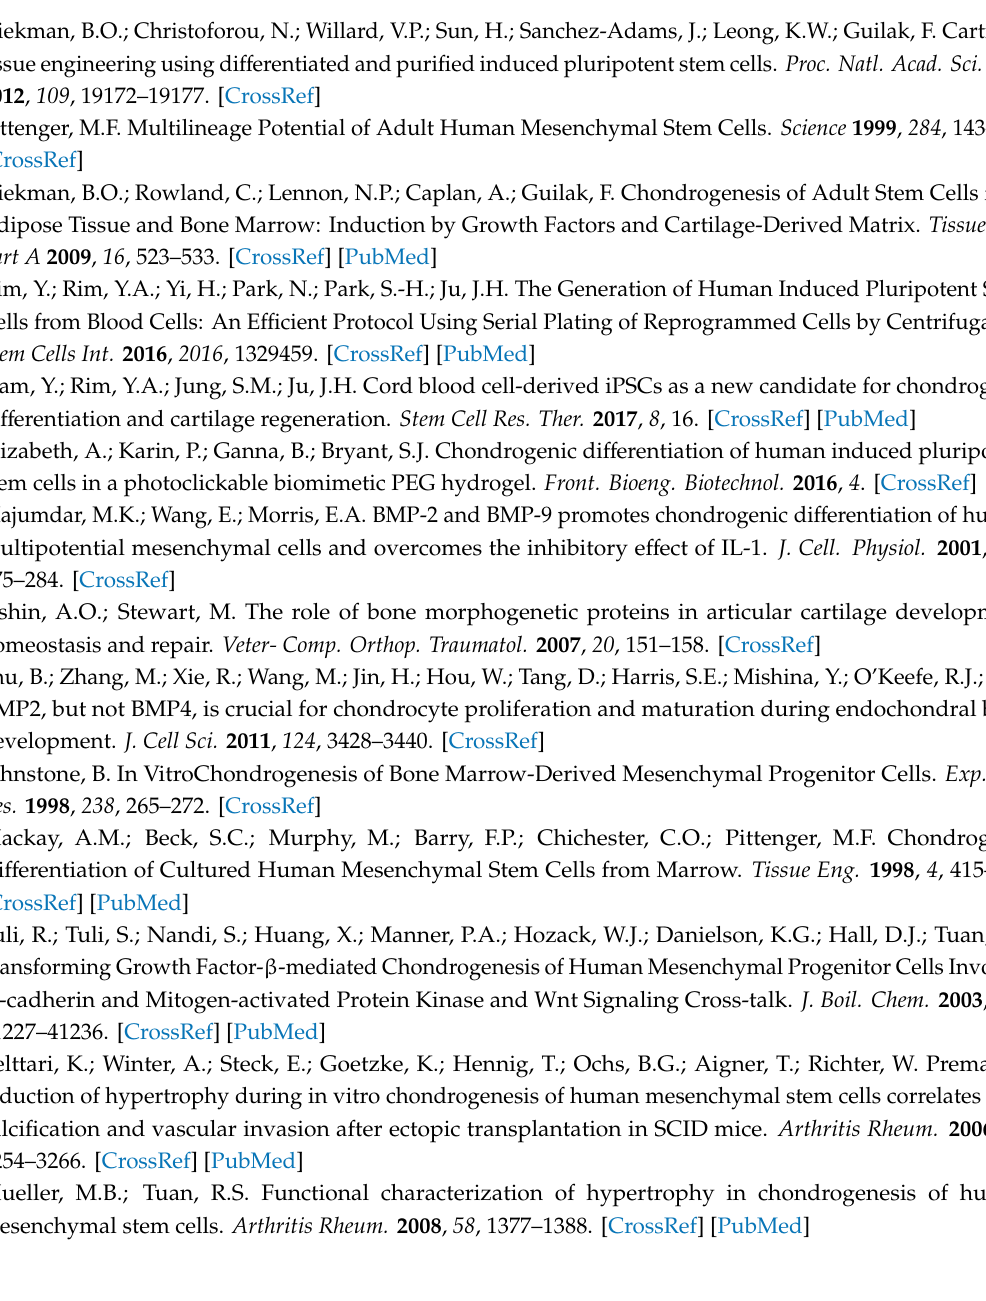
Figure S1: Relative expression of chondrogenic markers compared to human articular